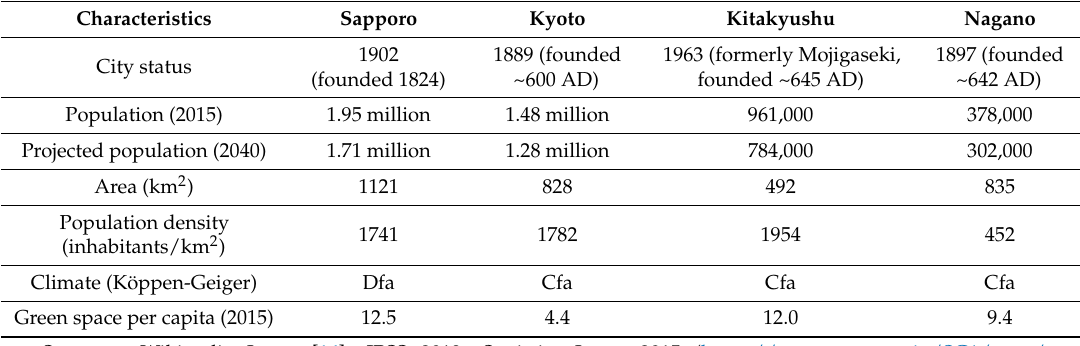
Table 1. Comparison of study